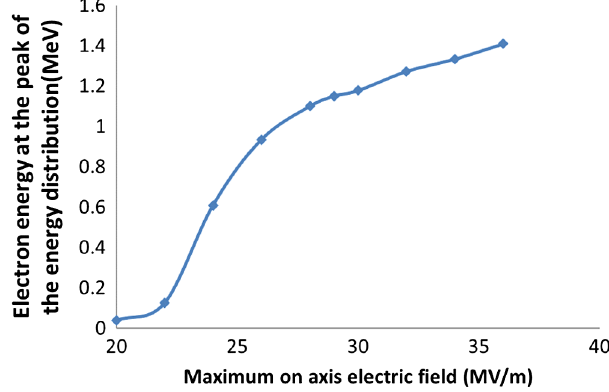
FIG. 11. Peak energy as a function of maximum electric field on axis from ASTRA.